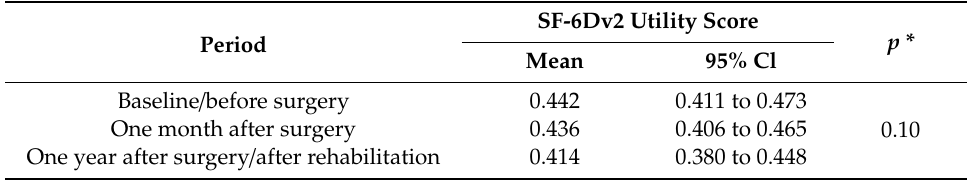
Table 6. SF-6Dv2 utility